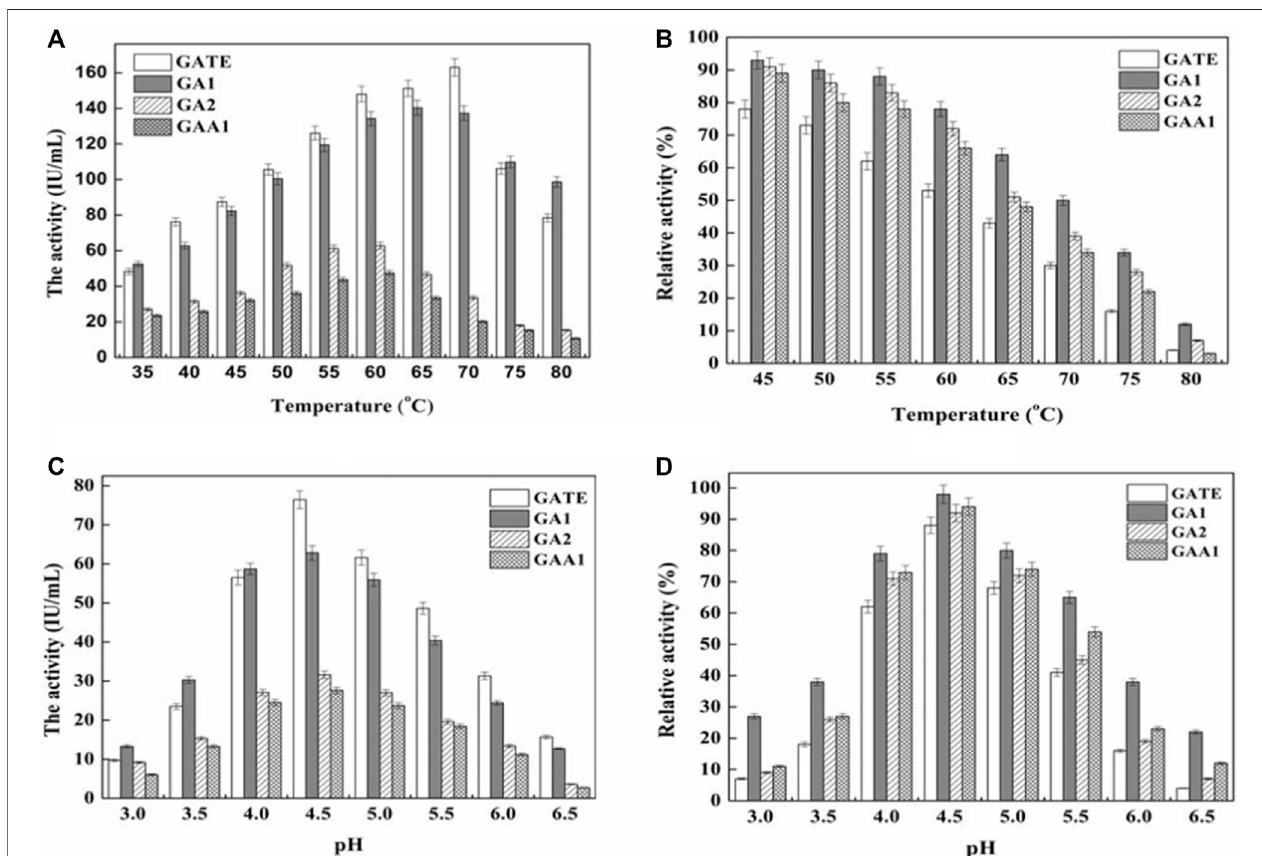
FIGURE 4 | Effect of temperature and pH on activities and stabilities of recombinant GAs. (A) Effect of temperature on the activity of the GA. GA activity was measured at various temperatures (35 – 80 ° C) at pH 4.5. (B) Thermal stability of the puri fi ed GA. After being kept at different temperatures (45 – 80 ° C) for six h and cooled down rapidly on ice, the residual enzyme activity of GA was measured at pH 4.5. The enzyme activity at optimal temperature was set as 100%. At 50 ° C, the relative activityofGATE,GA1,GA2,andGAA1was73,90,86,and80%,respectively,correspondingto100%.At60 ° C,therelativeactivityofGATE,GA1,GA2,andGAA1 was 53, 78, 72, and 66%, respectively, corresponding to 100%. (C) Effect of pH on GA activity. GA activity was measured in the pH range of 3.0 – 6.5 at 40 ° C. The maximumactivity wasobtainedatpH4.5. (D) pHstability oftheGA.GAactivity wasdeterminedafter beingkept atvariouspHvalues(3.0 – 6.5)for6 hat40 ° C.Astability curve of pH was plotted when the enzyme activity at optimal pH was set as 100%. The relative activity of GA1, GATE, GAA1, and GA2 was 98, 88, 94, and 92%, respectively.